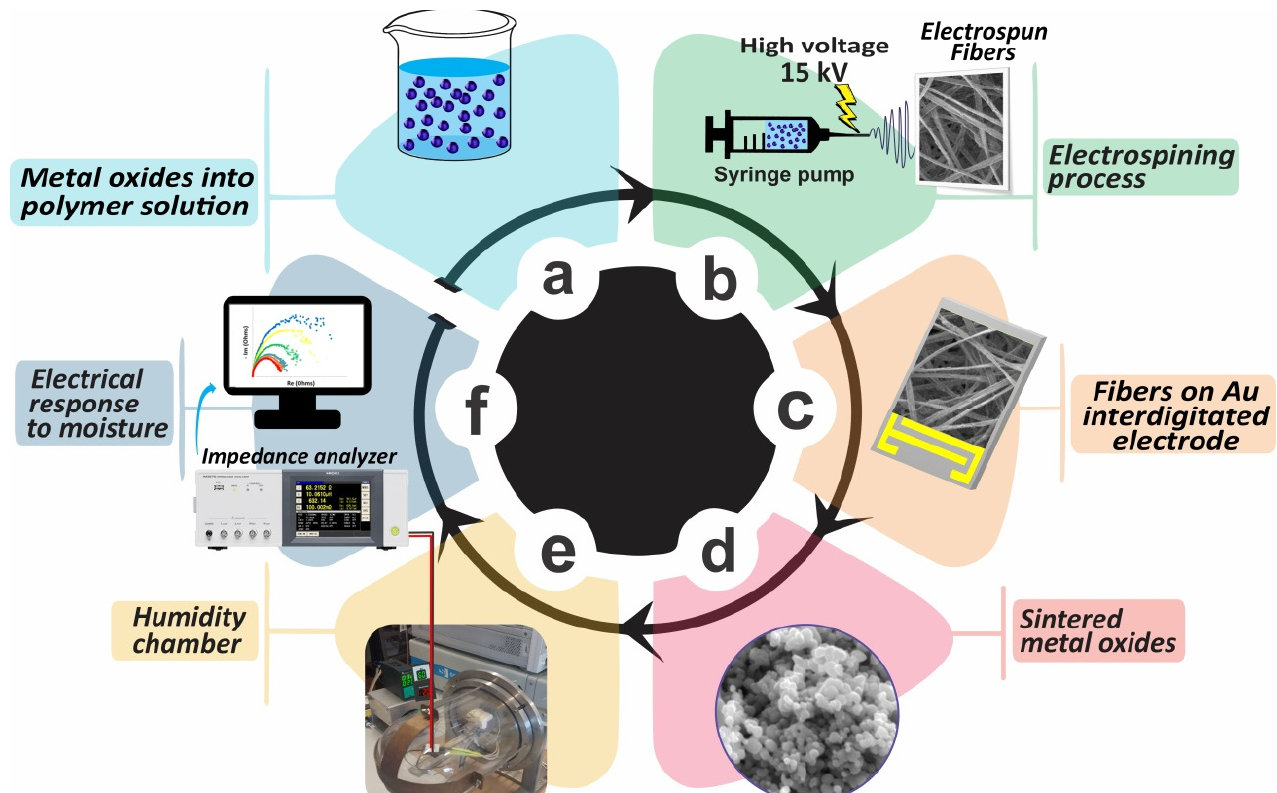
Figure 1. Schematic illustration of the sensor materials production and electrical response testing to RH. ( a ) Metal oxides into polymer solution; ( b ) electrospinning process; ( c ) fibers on electrodes; ( d ) sintered metal oxides; ( e ) humidity chamber used for electrical characterization; ( f ) impedance spectroscopy.